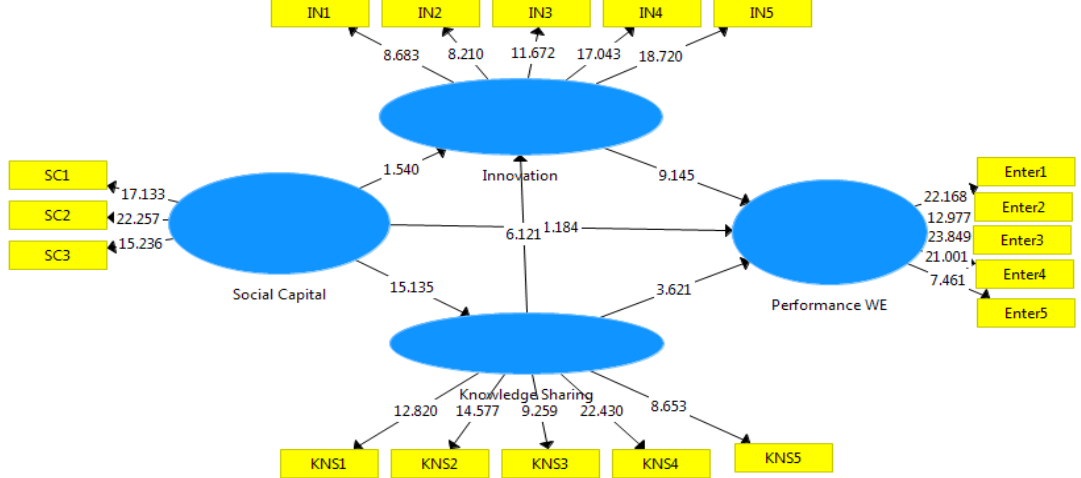
Figure 2. Empirical research model. Source: authors’